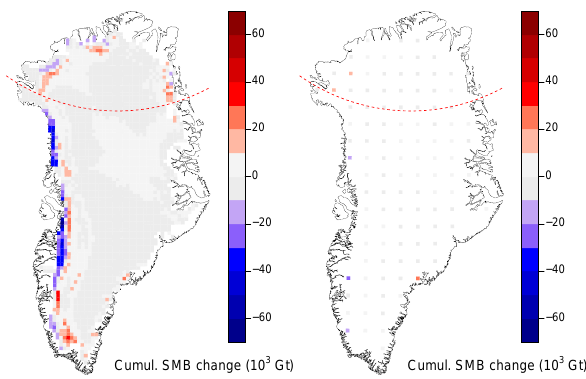
Fig. 9. Cumulative SMB change at the end of the NonUn 2080–2099 simulation: (left) error in the maximum likelihood gradient set ˜ b applied to the NonUn height change (adjusted minus perturbed), and (right) the subset of those grid cells used in the calculation of the weights (discrepancies f j i − z i in Eq.2.3). Reddashedlineis77 ◦ N. Fig. 10. Prior (blue) and posterior (red) distributions of cumulative change in sea level at 2099 using parameterised elevation feedback for height changes in the NonUn simulation. The target is the result from the NonUn 2080–2099 experiment (vertical black line).